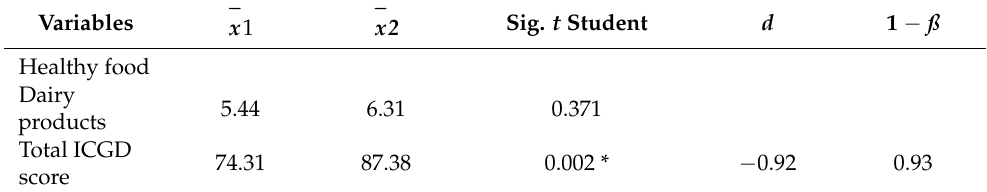
Table 3. Student’s t -test applied to food parameters evaluated in